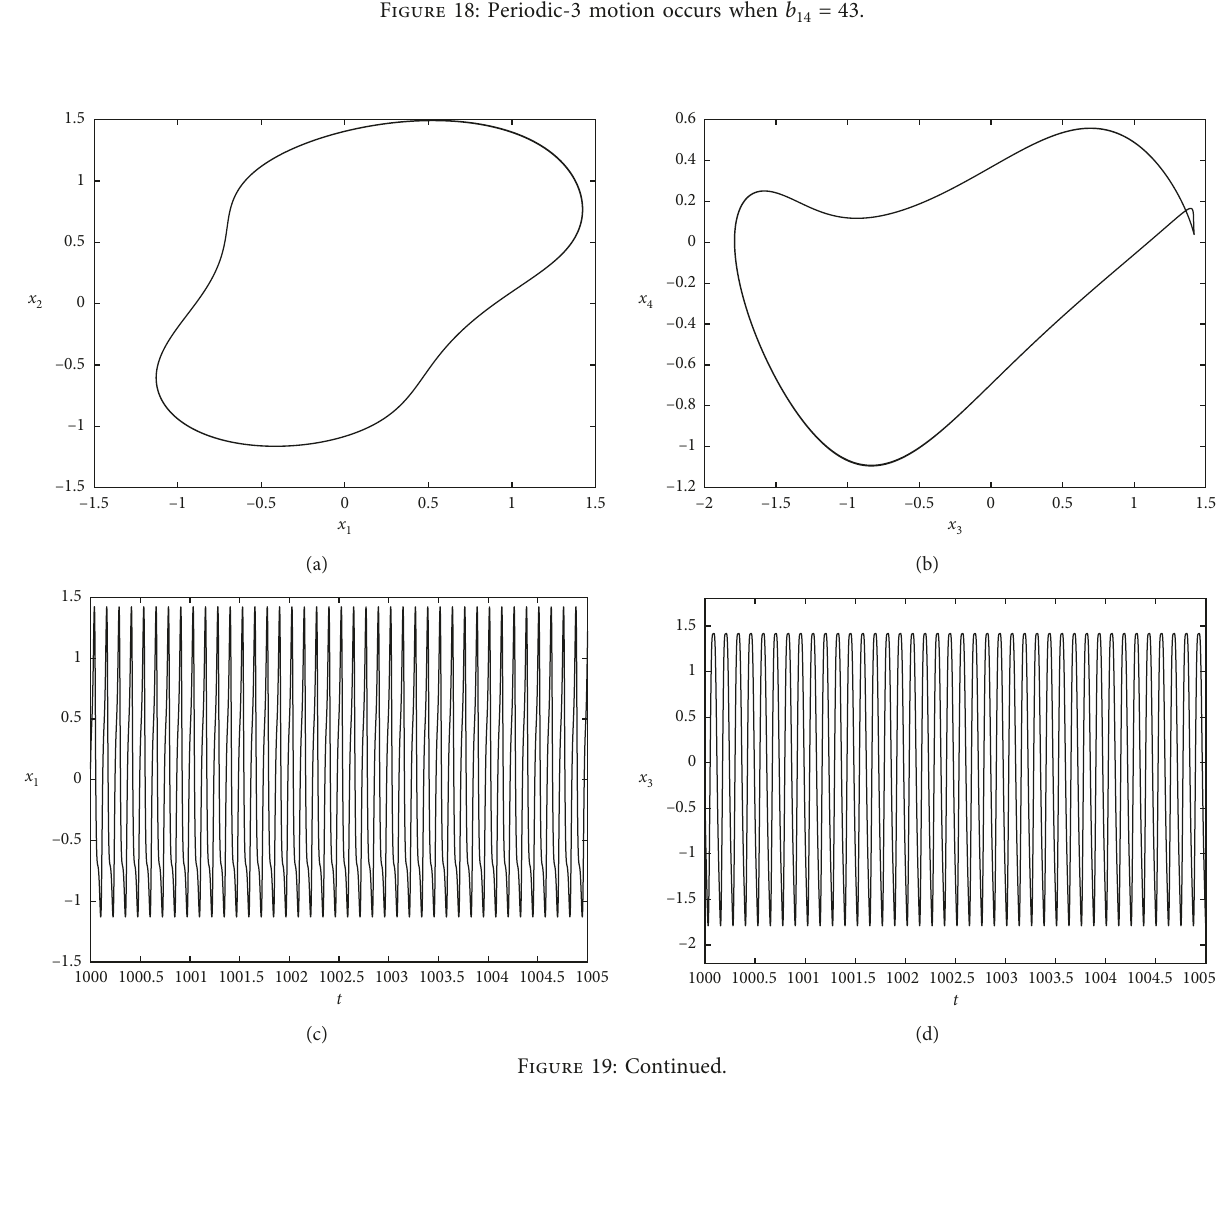
Figure 18: Periodic-3 motion occurs when b